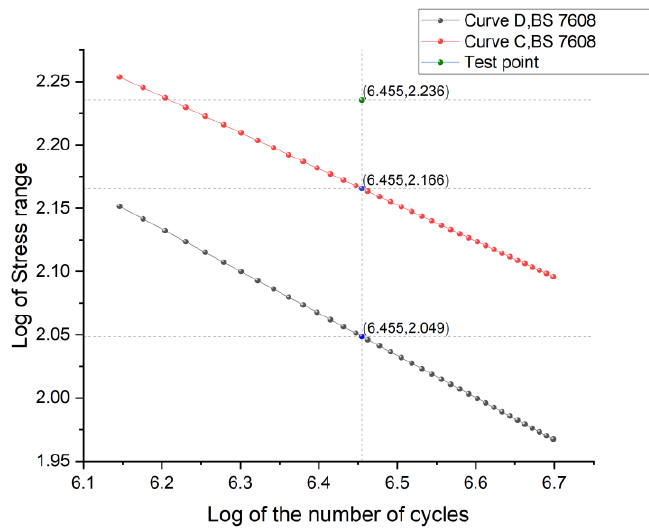
Figure 20. Calculation points in the S–N curve.